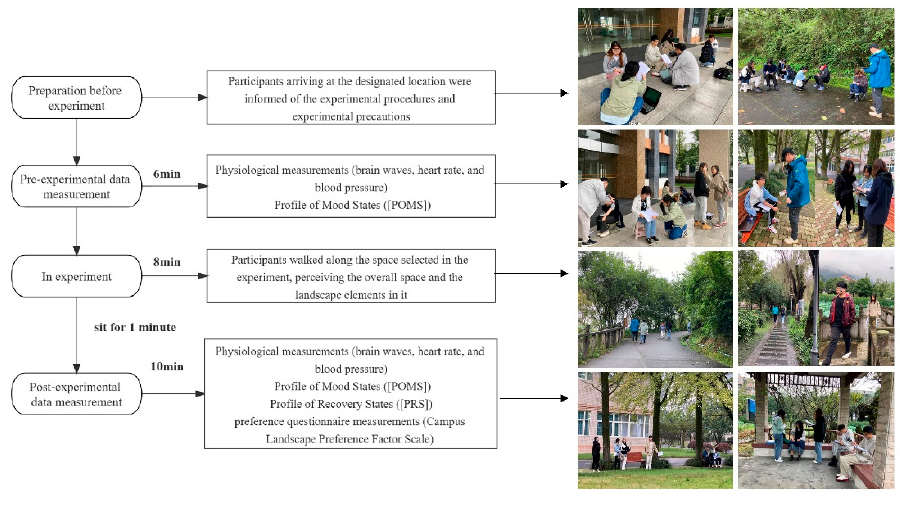
Figure 1. The Experimental